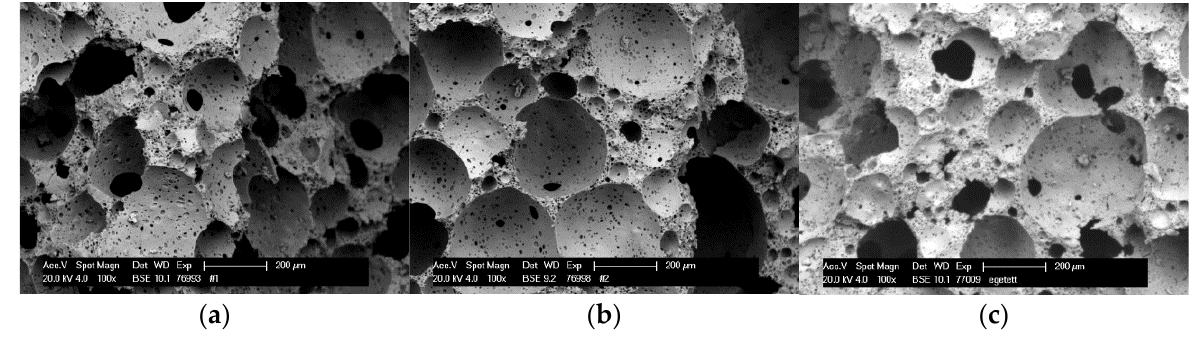
Figure 5. SEM micrograph of ( a ) unwashed, ( b ) washed and ( c ) fired samples of S-4.5.